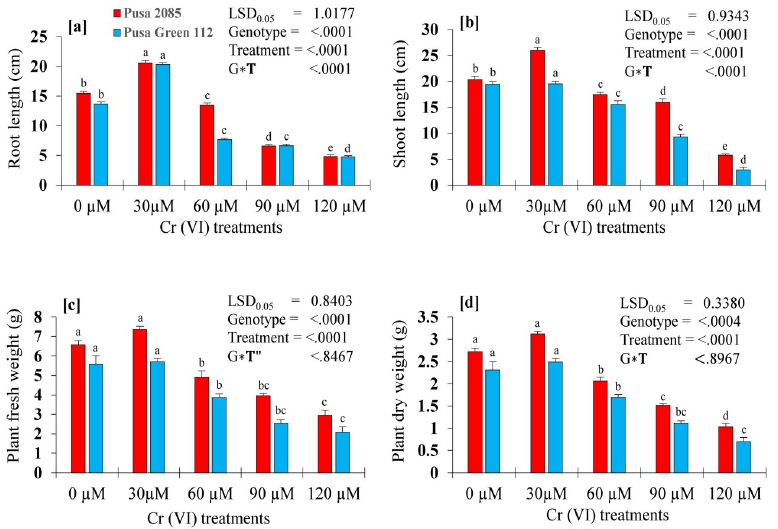
Fig 4. Effects of the various chromium (Cr) concentrations on two chickpea varieties (Pusa 2085 and Pusa Green 112) 21 days after treatment (DAT). (a) root length (cm). (b) shoot length (cm). (c) plant fresh weight (g). (d) plant dry weight (g). Values are means ± standard errors from three independent experiments. Error bars with the same letters are not significantly different at p � 0.05.